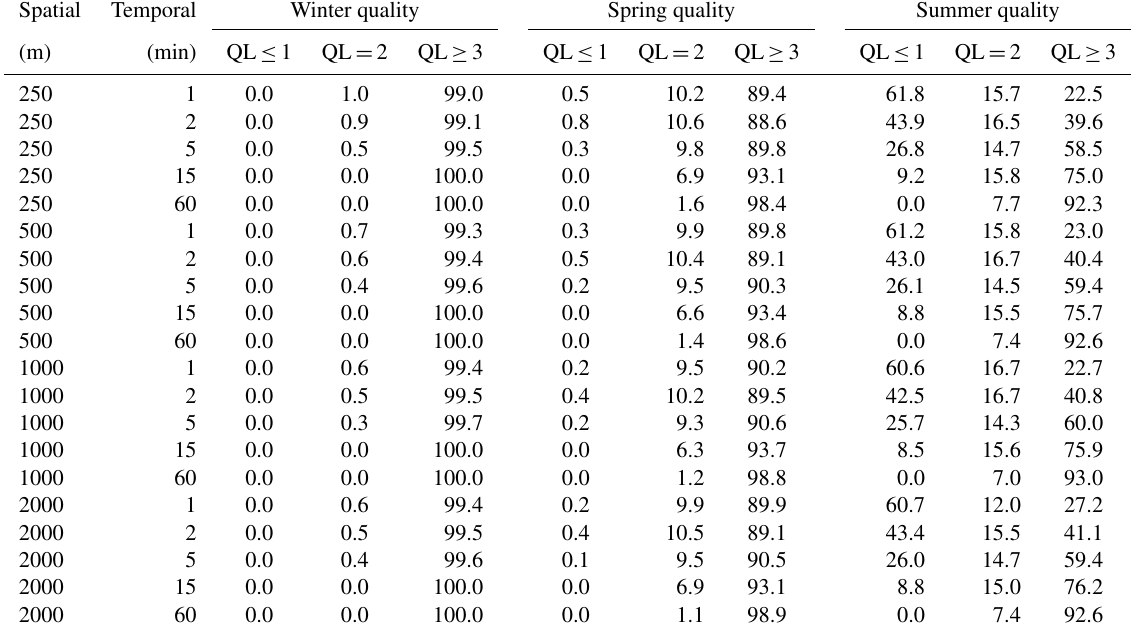
Table 1. Percent of grid cells (above land) within the study area (i.e. the full extent of Fig. 2), in three quality level categories (QL ≤ 1, QL = 2 and QL ≥ 3, summarized to improve readability of the table) at all temporal and spatial resolutions investigated, and for winter, spring and summer precipitation regimes.